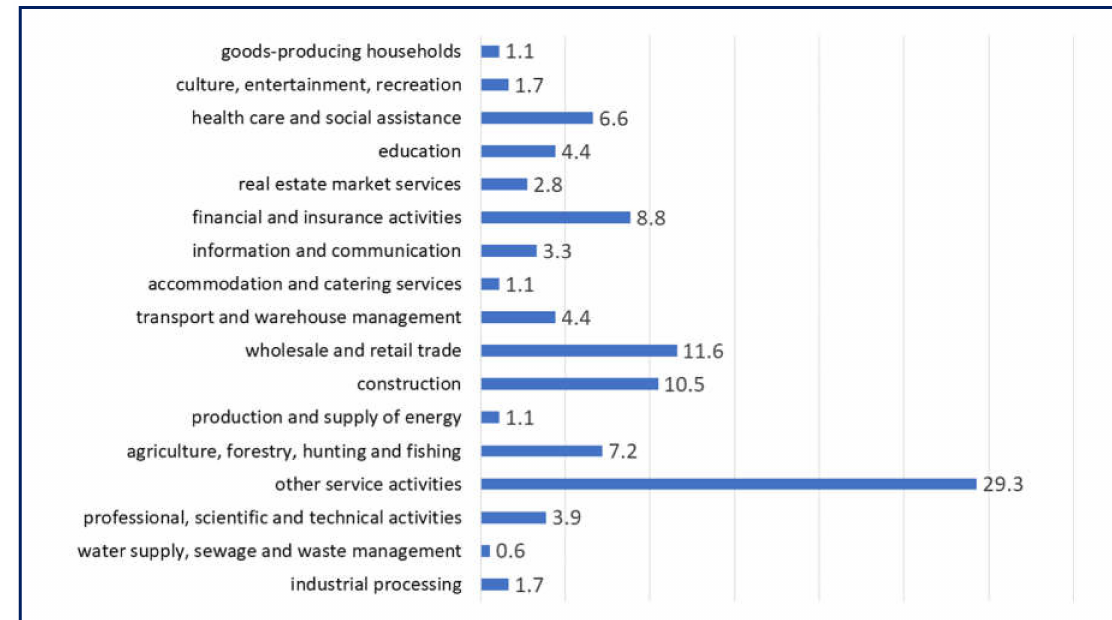
Figure 3. Enterprises due to the business sector (N = 181, %).